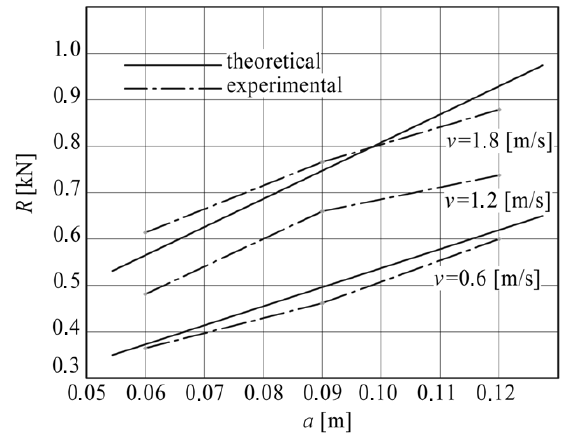
Figure 18. The dependence of the tractive resistance of the sowing section (with the slotting disk) R on the working speed and the tilling depth of the colter at P5=2.0kN